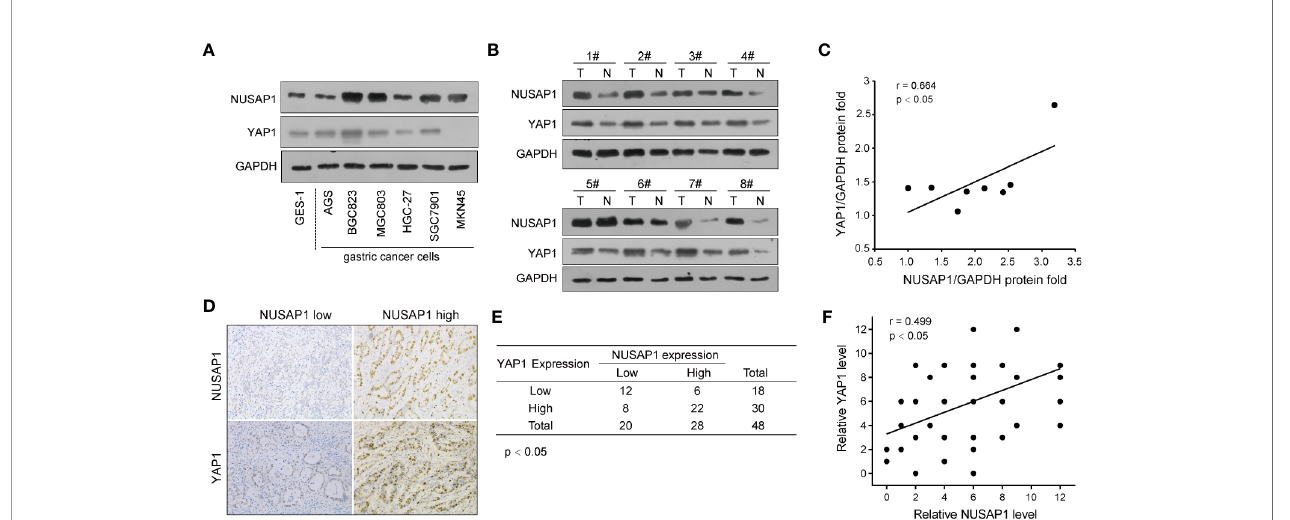
FIGURE 7 | NUSAP1 expression positively correlates with YAP1 protein levels in GC. (A) Western blotting analysis of NUSAP1 and YAP1 levels in GES-1, AGS, BGC823, MGC803, HGC-27, SGC7901, and MKN45 cell lines. GAPDH was used as a loading control. (B) Western blotting analysis of NUSAP1 levels in lysates prepared from 8 paired GC tissues and normal gastric tissues. (C) The correlation analysis of NUSAP1 and YAP1 expression levels in 8 GC patients. (D) Representative immunochemical staining of NUSAP1 and YAP1 in GC tissues. (E, F) Correlation of NUSAP1 expression with YAP1 expression in primary 48 GC patients (Pearson ’ s correlation coef fi cient, the chi-square test, p